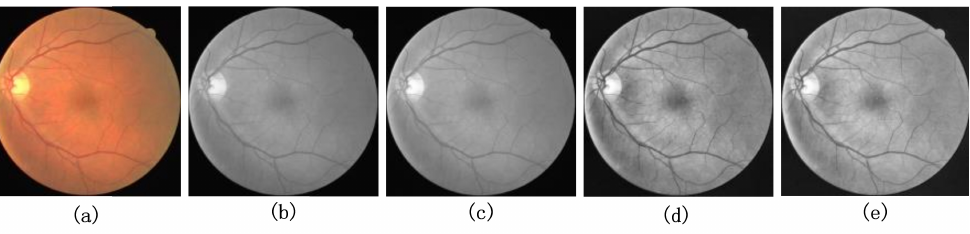
Figure 7. Pre-processing results of ( a ) original retinal fundus vessel medical image, ( b ) RGB three- channel scaled fusion image, ( c ) data normalized image, ( d ) CLAHE processed image, and ( e ) gamma corrected